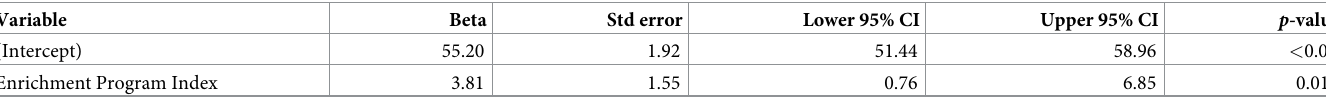
Table 6. Results for the final model examining dive